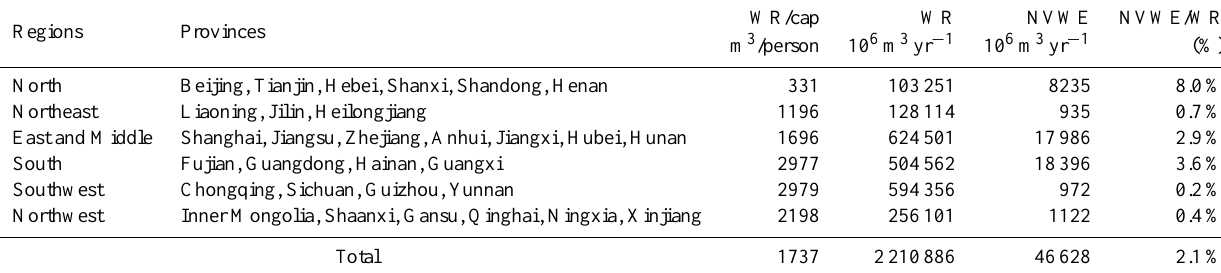
Table 3. Net virtual water export (NVWE) and water resources (WR) in different regions (2002).